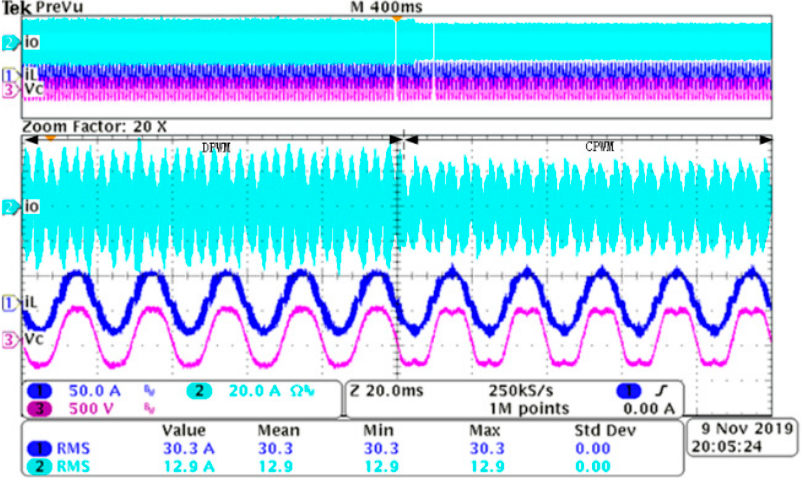
Figure 4. Harmonics comparison between continuous pulse-width modulation (CPWM) and discontinuous pulse-width modulation (DPWM). ( a ) CPWM zero sequence quantity. ( b ) PPWM zero sequence quantity. ( c ) Single-sided amplitude spectrum of Z CPWM . ( d ) Single-sided amplitude spectrum of Z DPWM.